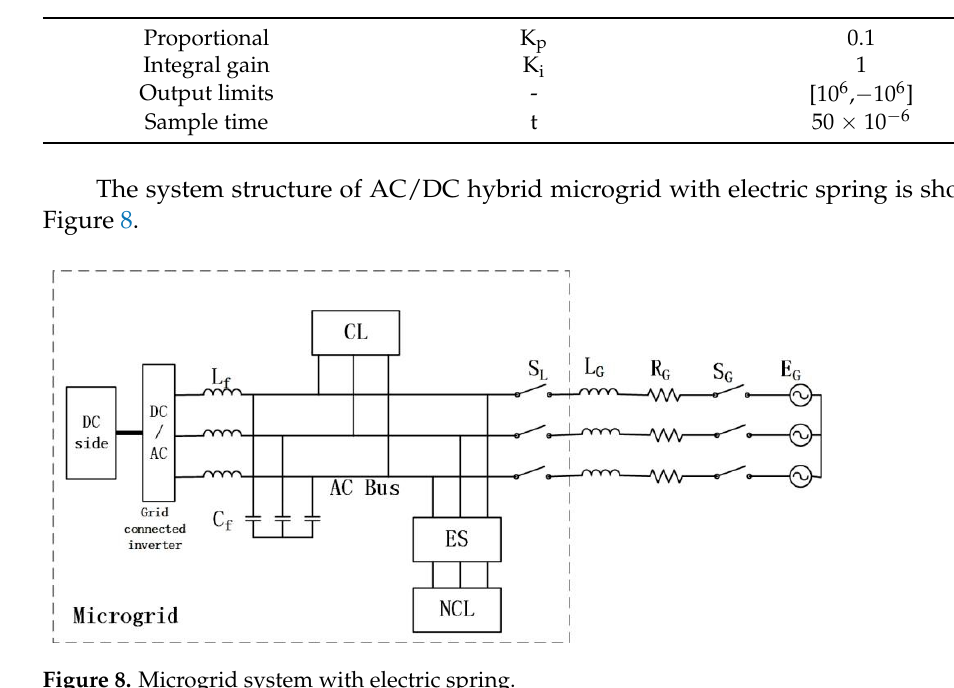
Table 4. Main parameters of the PI controller.